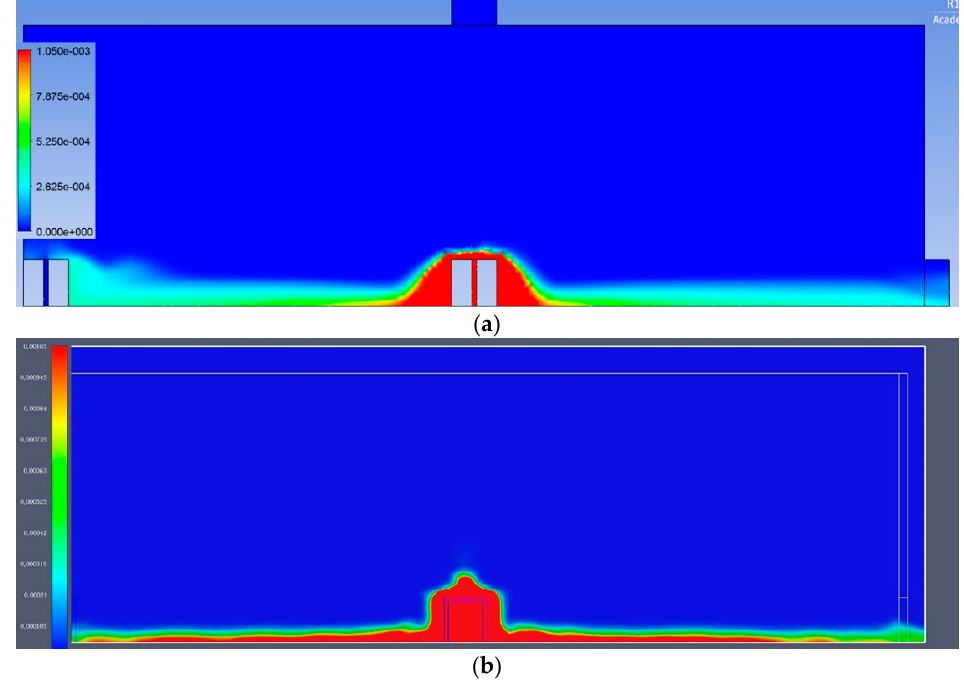
Figure 11. Comparison of propane dispersion for 5% concentration of LEL for time 250 s: ( a ) propane release calculated with Ansys software; ( b ) propane release calculated with FDS software.